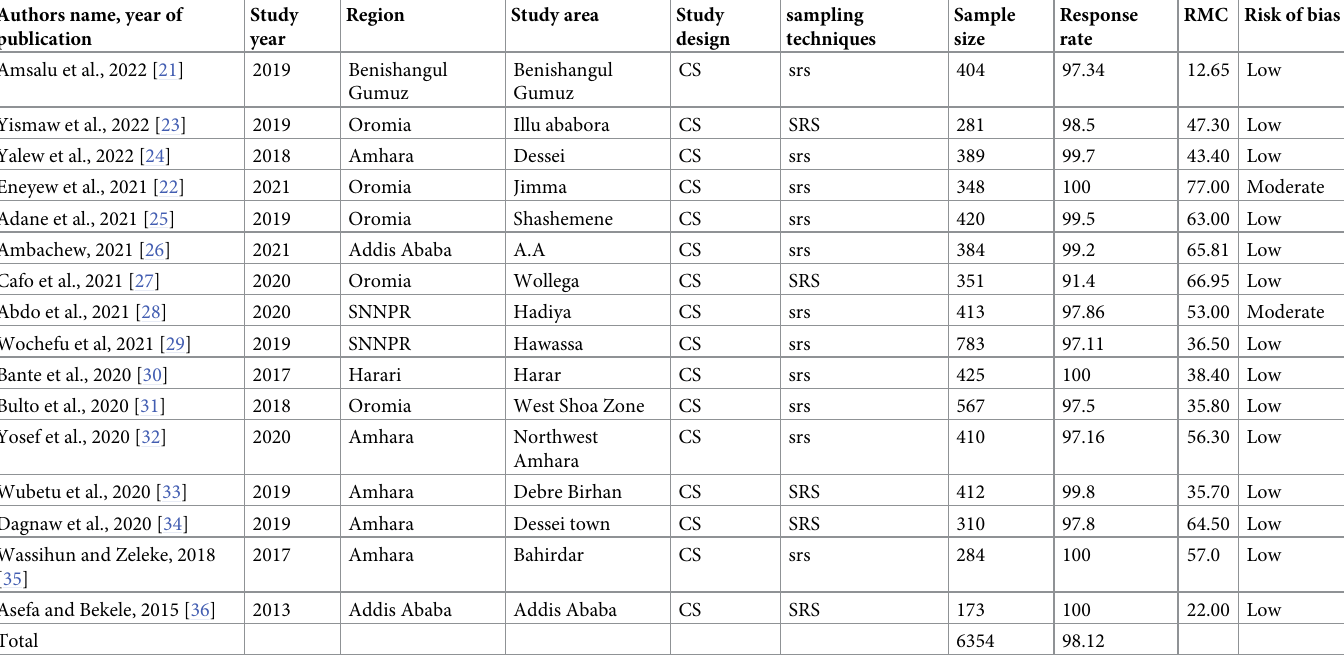
Table 1. Descriptive summary of studies included in systematic review and meta-analysis of the prevalence of RMC and its determinants in Ethiopia,